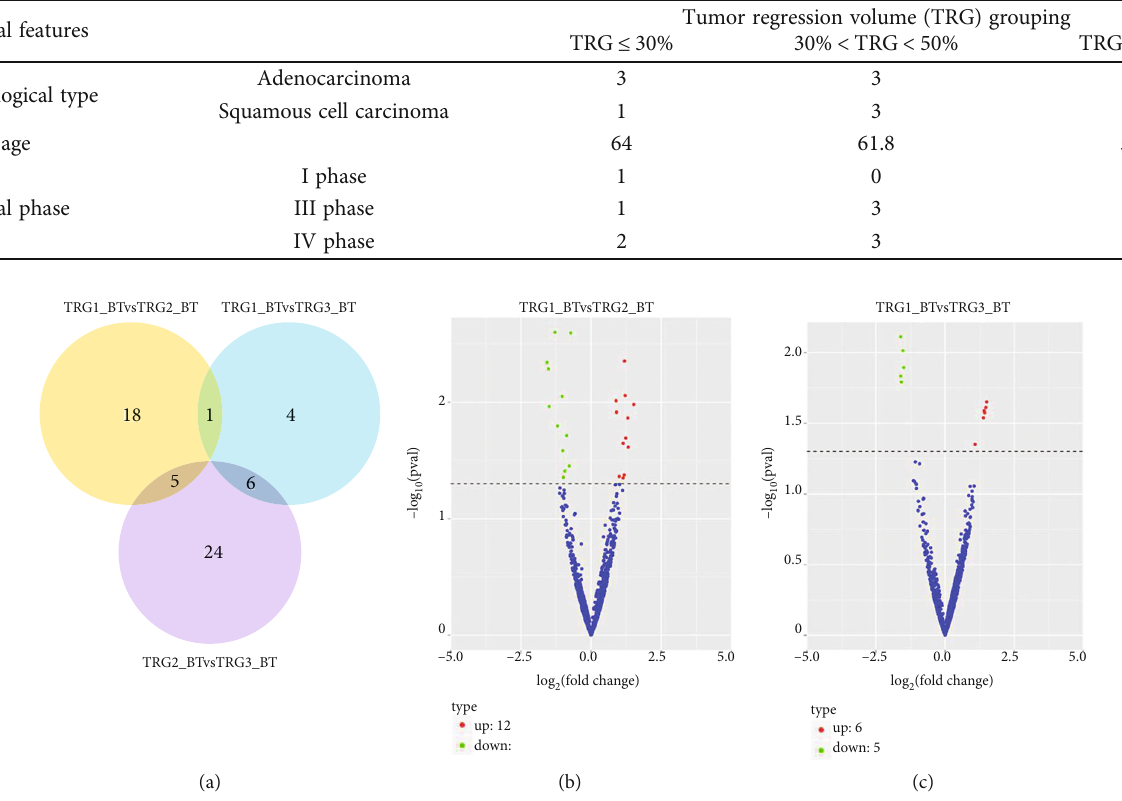
Figure 1: Screening of di ff erentially expressed genes. (a) Venn plot of common di ff erentially expressed genes. (b) Volcano plot of the di ff erentially expressed miRNAs of the TRG1 and TRG2 groups. (c) Volcano plot of the di ff erentially expressed miRNAs of the TRG1 and TRG3